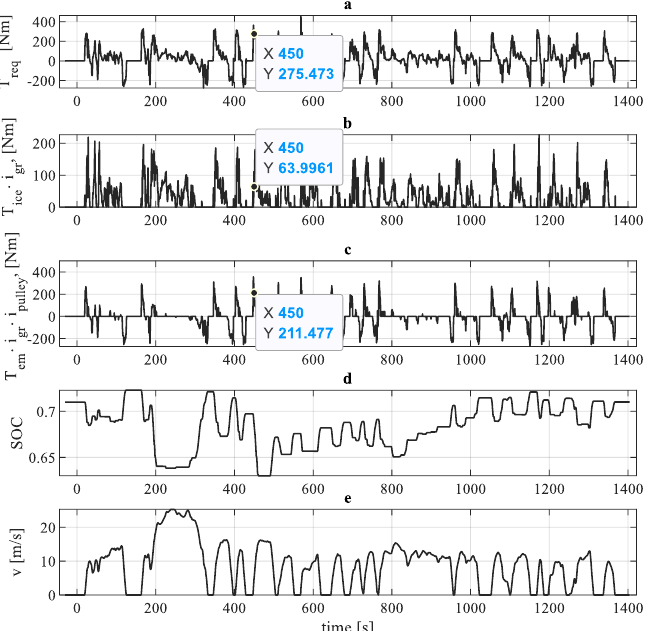
Figure 7. ( a ) Requested torque, ( b ) engine torque, ( c ) EM torque at the gearbox output level, ( d ) SOC profile under ECMS controller without TCF, and ( e ) vehicle velocity